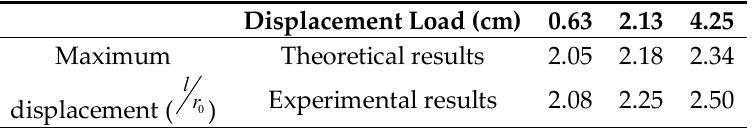
Table 2. Experimental and theoretical results of the maximum displacement under different displacement